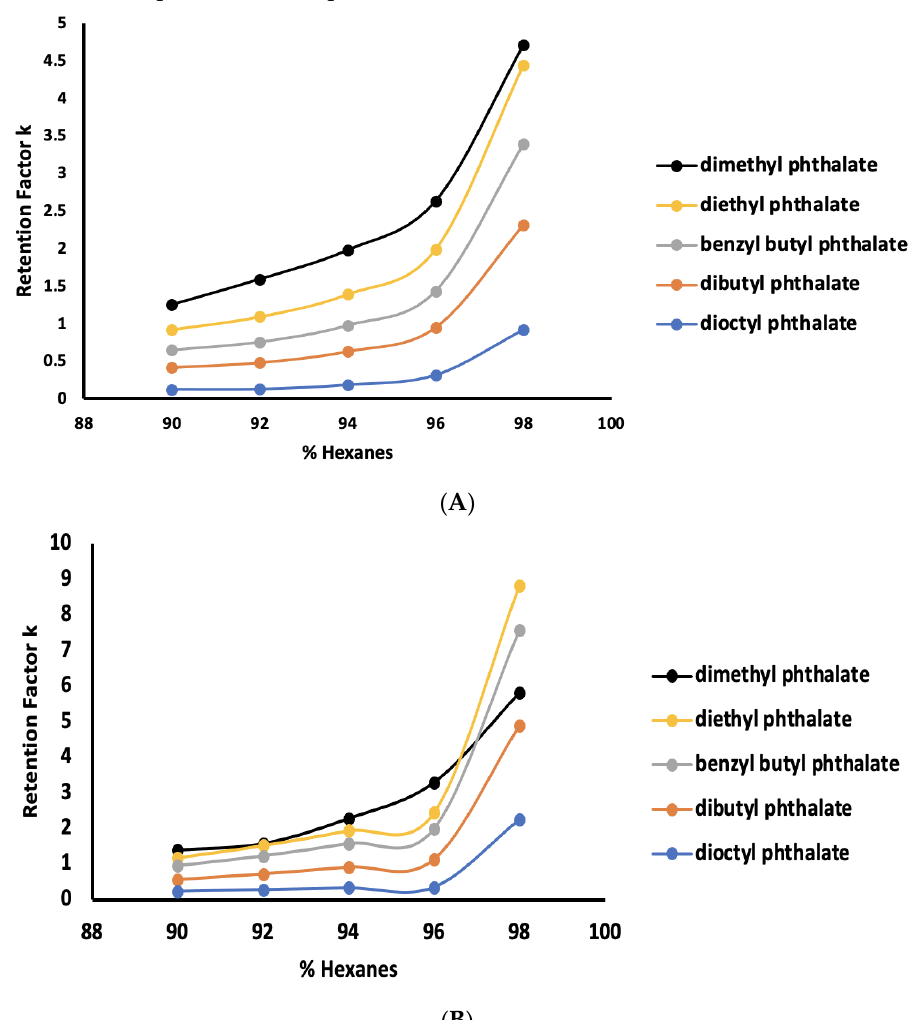
Figure 1. Retention factor plots of phthalates as a function of organic modifiers (increases to the left): ( A ) ethyl acetate and ( B ) dimethyl carbonate in hexane. Top to bottom at 4% organic modifier: dimethyl phthalate, diethyl phthalate, benzyl butyl phthalate, dibutyl phthalate, and dioctyl